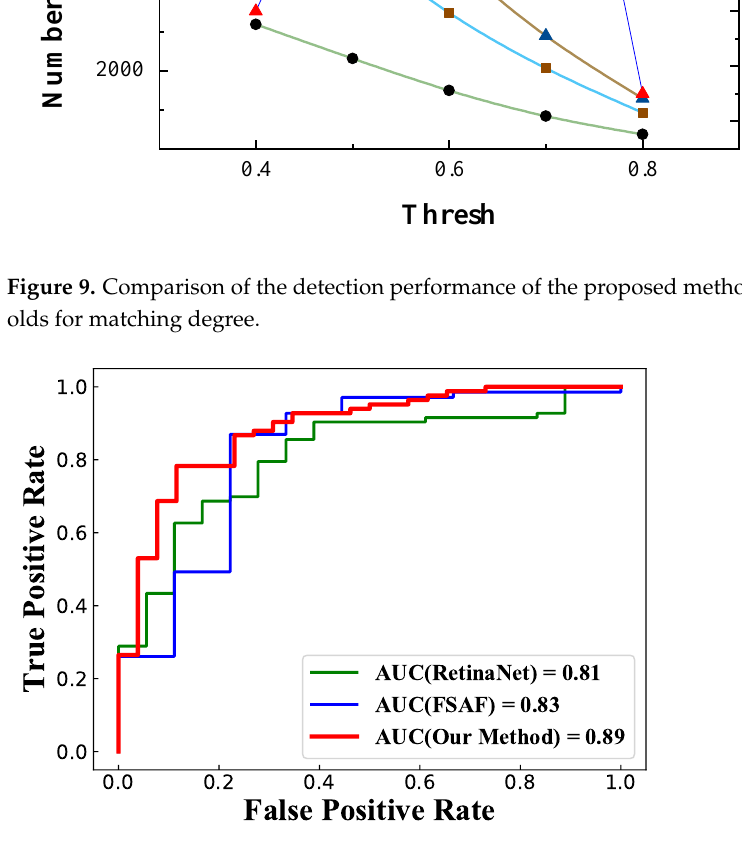
Figure 10. ROC curve of our method and the compared deep learning detection